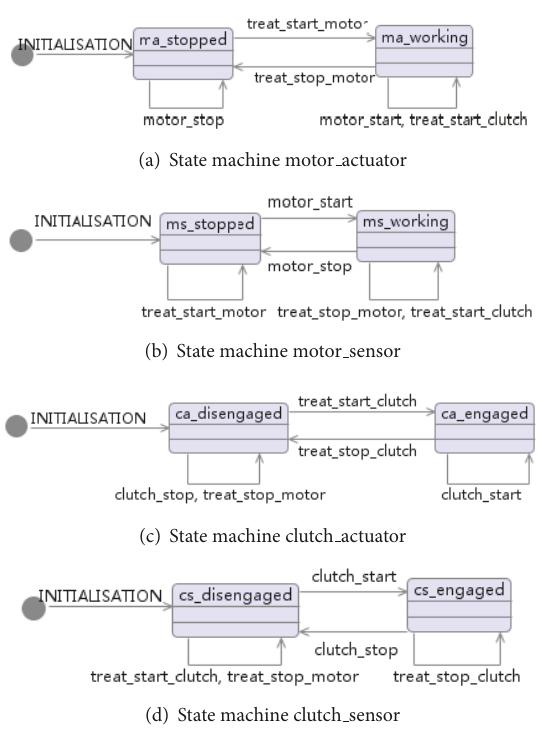
Figure 16: Instance state machines of Sub5 and